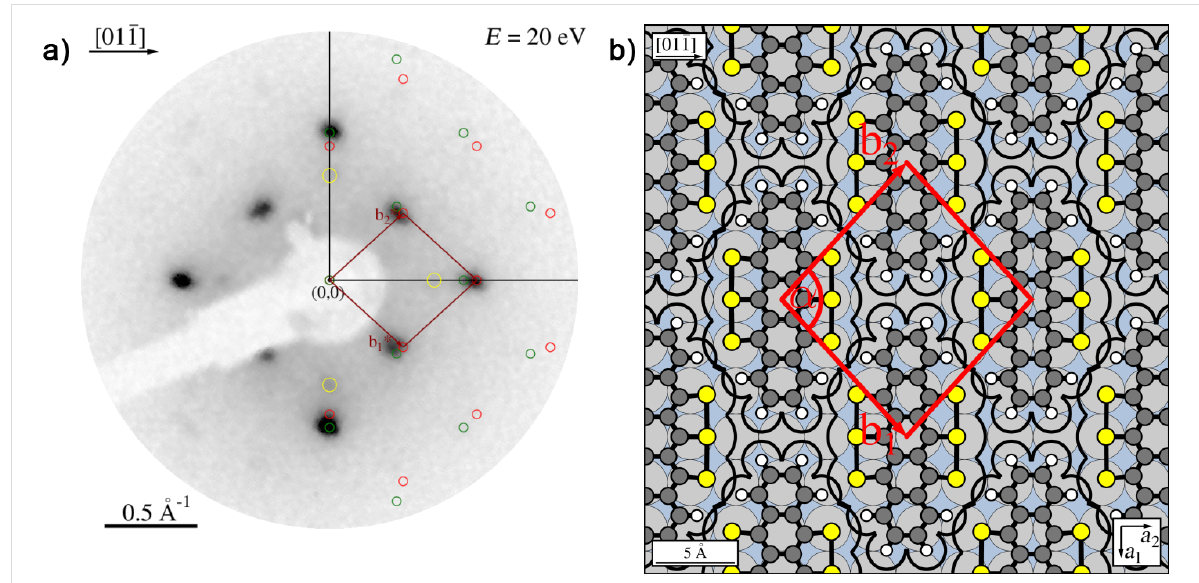
Figure 3: Compressed superstructure of HTPEN on Ag(100). (a) LEED pattern at an electron energy of 20 eV. A simulated diffraction pattern is over- laid. Green and red spots correspond to the two symmetry-equivalent domains rotated by 90° with respect to each other. Very faint spots marked by the yellow circles are due to multiple electron scattering. These are obtained by adding the vector of the first-order substrate spots (2.18 Å − 1 ) to those of the strong second-order HTPEN spots. (b) Hard-sphere model of the compressed structure of